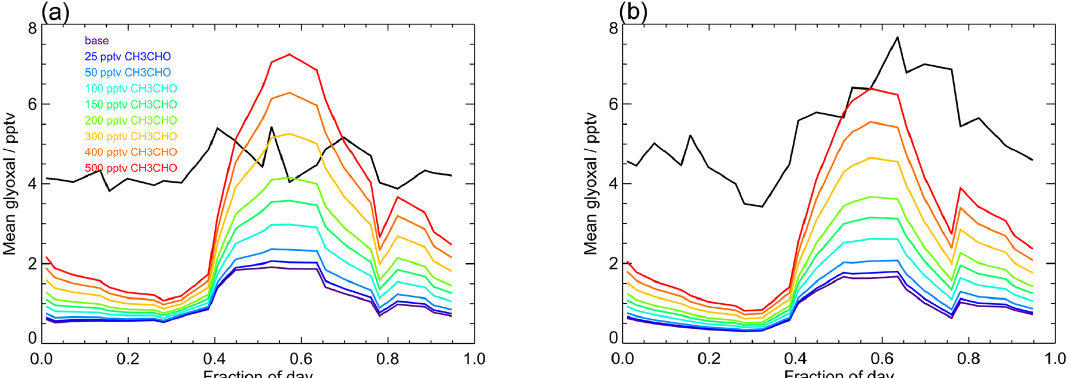
Figure 12. Average observed (black) and modelled glyoxal diurnal profiles showing the sensitivity of the model to mixing ratios of acetalde- hyde. The base model run includes only acetaldehyde produced within the model by the oxidation of VOCs constrained in the model (Table 1) and has mean acetaldehyde mixing ratios of (14 . 2 ± 6 . 5)pptv during campaign 1 (median 15.0pptv) and (15 . 0 ± 5 . 6)pptv during campaign 2 (median 16.3pptv). For model runs performed to investigate the sensitivity of the model to acetaldehyde, the acetaldehyde mixing ratio in each simulation was fixed to a constant mixing ratio between 25 and 500pptv, as indicated in the